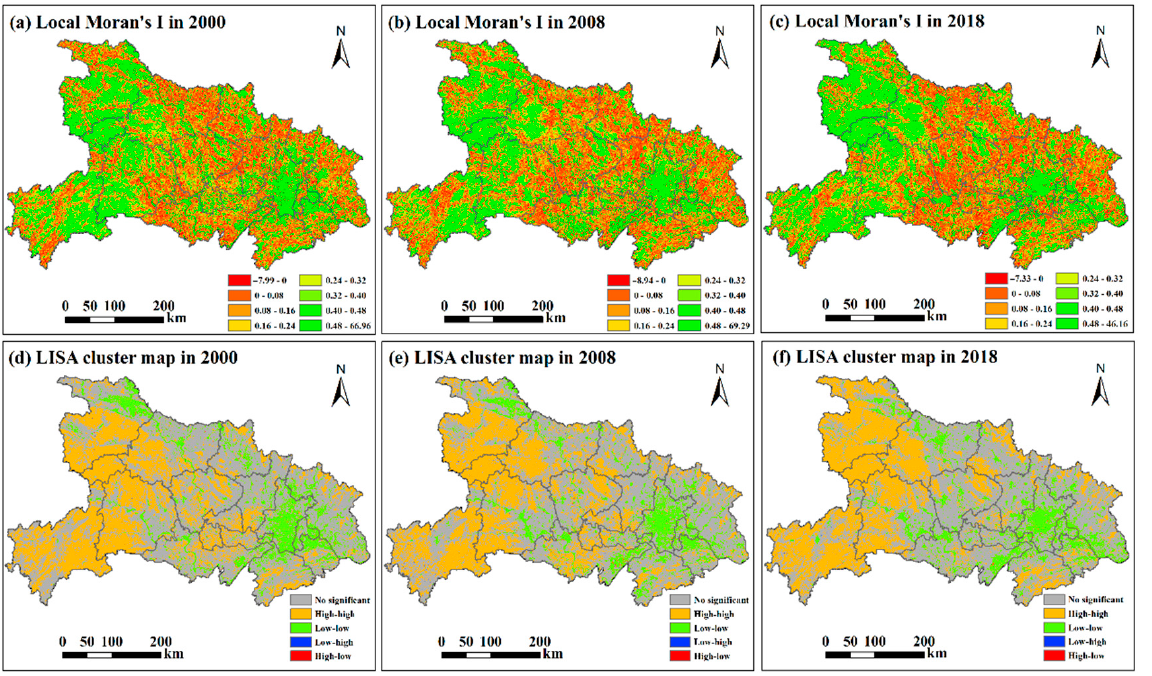
Figure 6. Distribution of local Moran’s I in 2000 ( a ), 2008 ( b ), and 2018 ( c ), and LISA cluster maps in 2000 ( d ), 2008 ( e ), and 2018 ( f ).